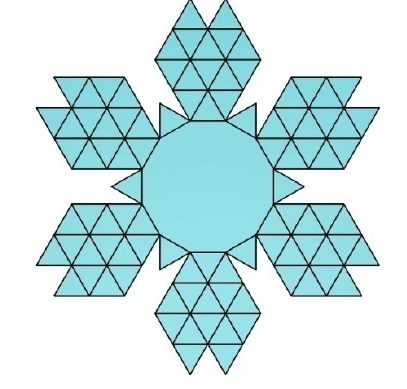
Figure 9. The planar net CP IV-12B Heights of all vertices of Concave pyramids of the fourth sort above the dodecagonal polygonal base are shown in Table 2. Table 2. Heights of all vertices of CP